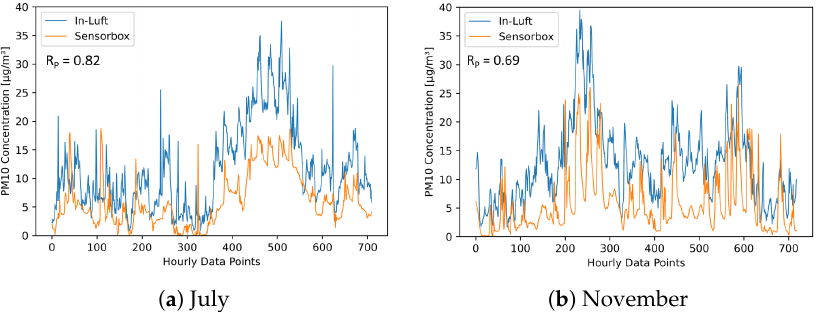
Figure 22. PM 10 hourly mean data recorded with mobile pilot sensor-box 8 located in Cham compared to hourly mean data recorded at the in-luft station located in Zug, Postplatz. Data gaps are removed from the graph. ( a ) N = 710, R P = 0.82, R S = 0.81; ( b ) N = 719, R P = 0.69, R S = 0.70.